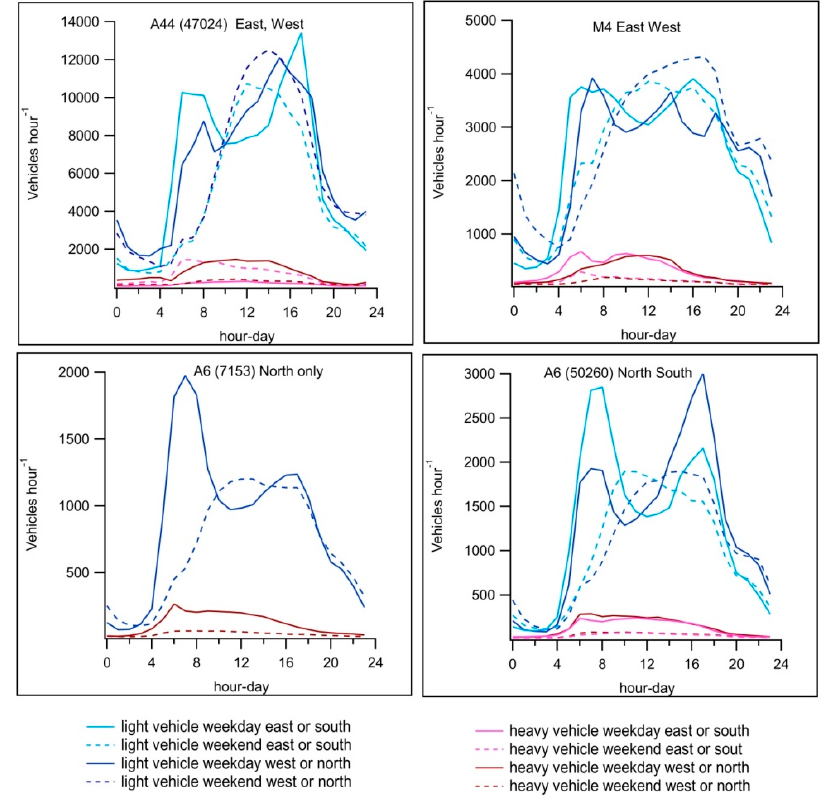
Figure A1. Map shows the location of the measurement site ( (cid:0) ) within the Sydney greater area. For location ( (cid:0) ), on roof of 2 story building and retro ‐ reflectors (  ) on roof of 3 story building at the FigureA1. Mapshowsthelocationofthemeasurementsite( reference the Sydney Harbor Bridge is marked (  ). The edge of the residential area and the start of edge of the small business district in Auburn is located. The measurement path (395 m) is marked ( ‐ agricultural areas can be seen on the east. It is 17 km from the measurement site to the Sydney ). There is a major intersection in the north ‐ east. To the east is light industrial area, with mainly Harbor Bridge. residential to the east. The measurement path crosses a railway line and a major intra ‐ urban